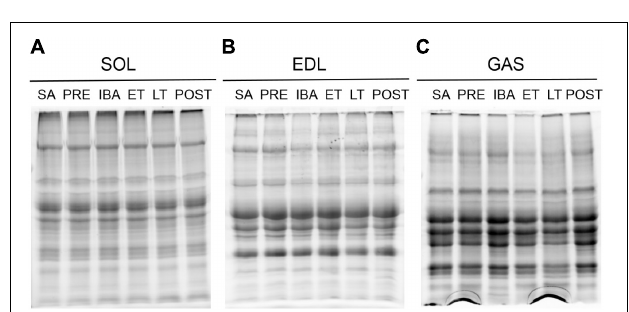
FIGURE 4 | Stain-free imaging of separation gel. (A) In the SOL. (B) In the EDL. (C) In the GAS. SOL, soleus; EDL, extensor digitorum longus; GAS, gastrocnemius. SA, summer active; PRE, pre-hibernation; IBA, interbout arousal; ET, early torpor; LT, late torpor; POST, post-hibernation.